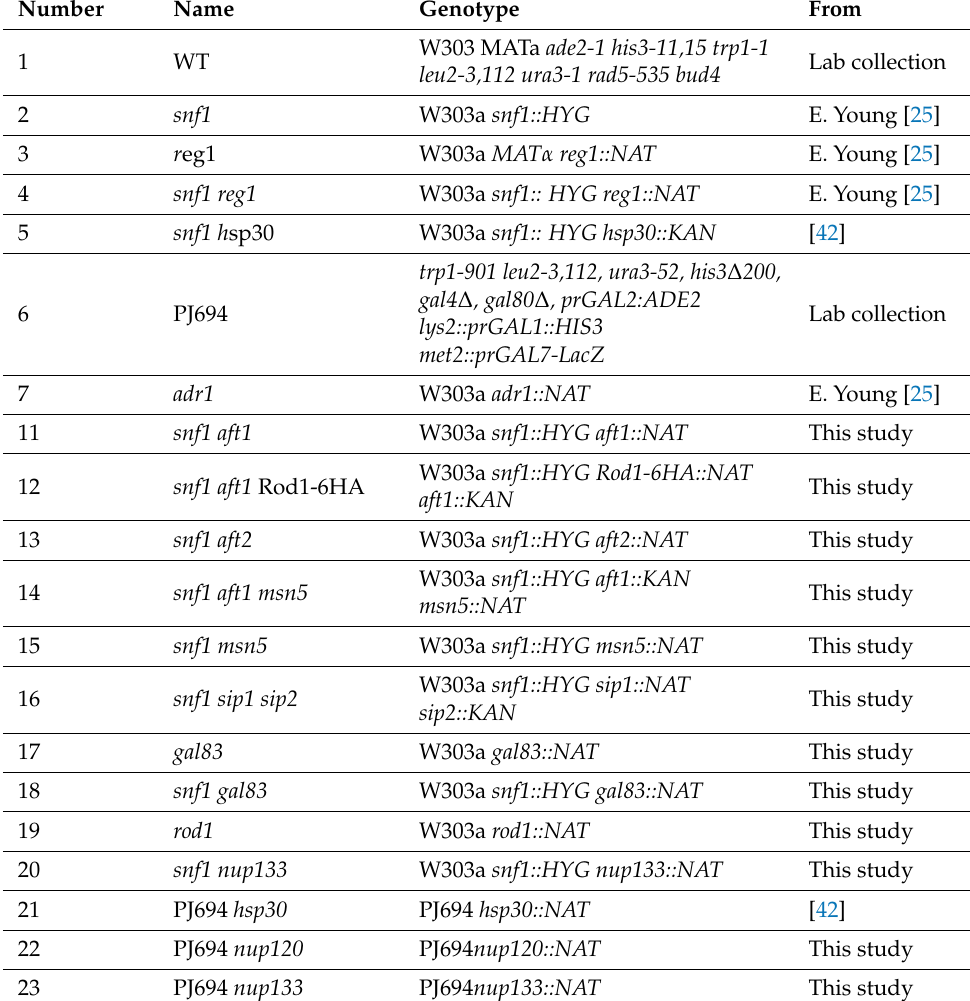
are listed in Table 2. Oligonucleotides used for mutagenesis of Snf1, Aft1, and Pma1 are listed in Table 3. All strains are related to W303a, except for PJ694, which was used for yeast 2-hybrid assays. Yeasts were transformed with DNA using the frozen lithium acetate method [81]. The construction of poly-amino acid substitutions in Snf1 and the exchange of selective markers in plasmids was by gap repair [82] and